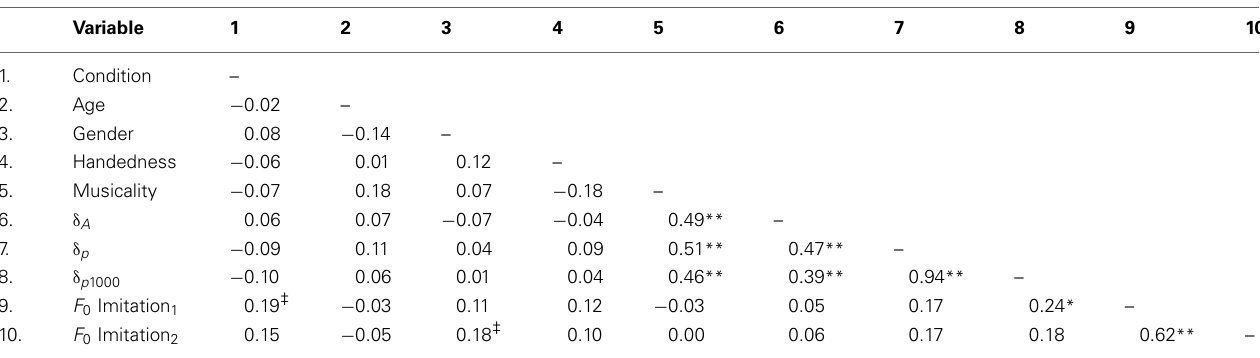
Table 3 | Zero-order Pearson product-moment correlations among psychoacoustic variables and the socio-demographic variables.